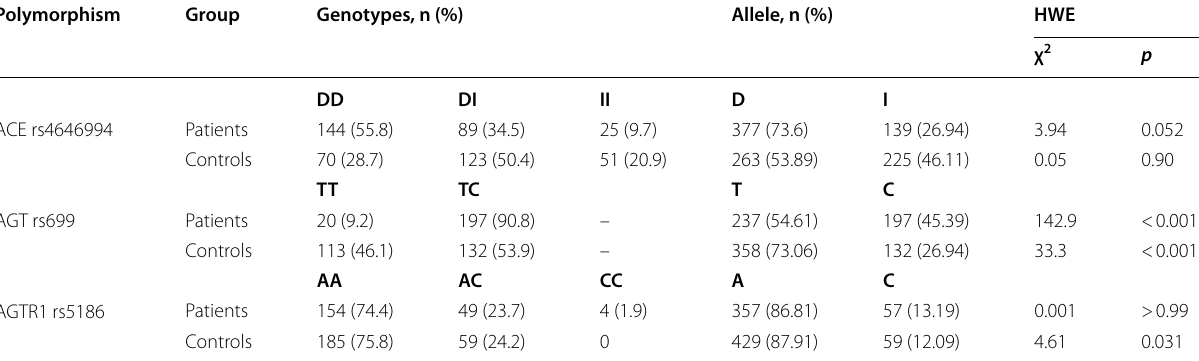
Table 4 Alleles and genotypes frequencies of ACE rs4646994, AGT rs699 and AGTR1 rs5186 polymorphisms in COVID-19 patients and control